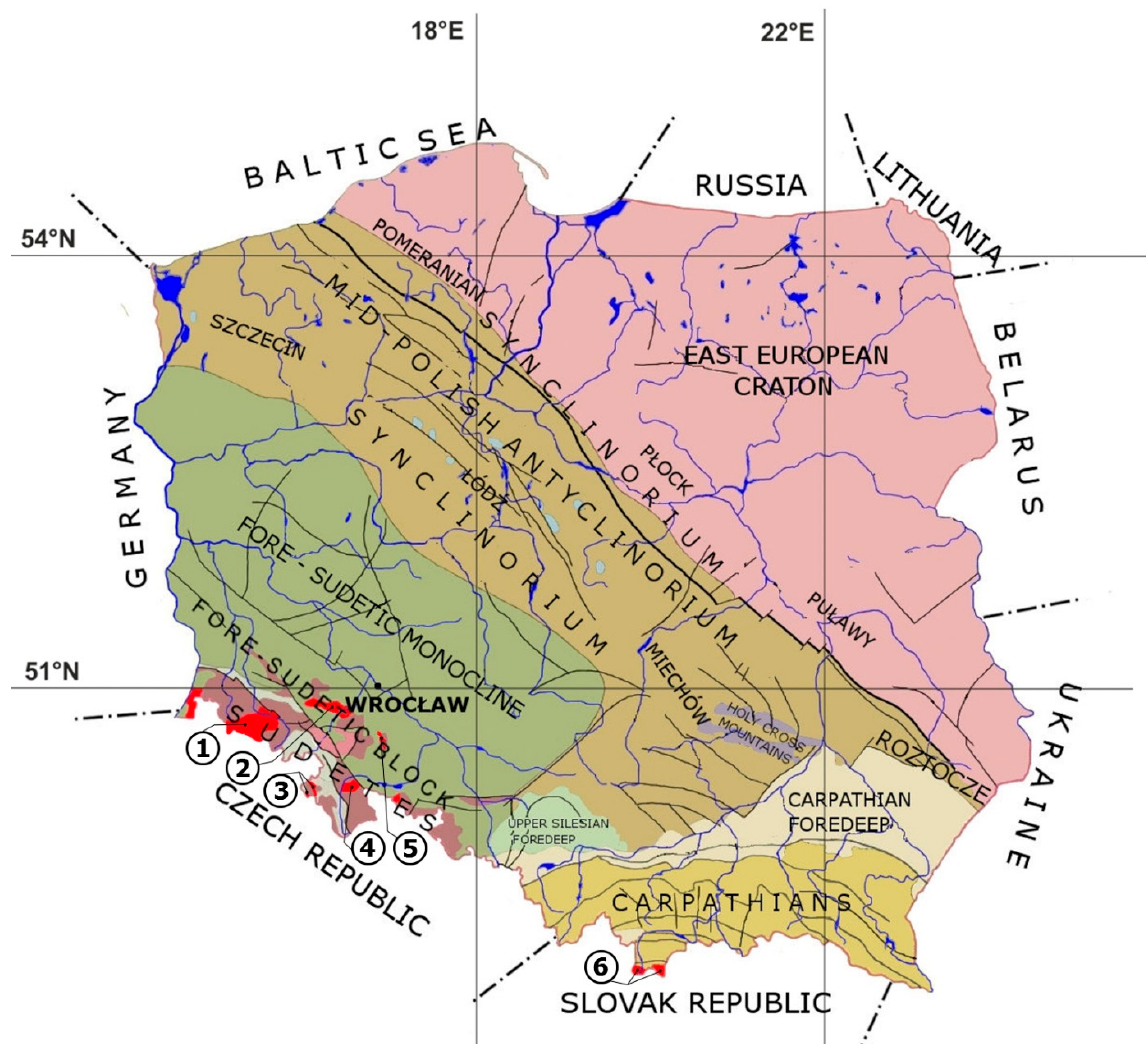
Figure 1. Location of granitoid massifs on a simplified tectonic map of Poland without Cainozoic deposits (according to [48–50]; slightly modified). 1–Karkonosze granite, 2–Strzegom-Sob ó tka